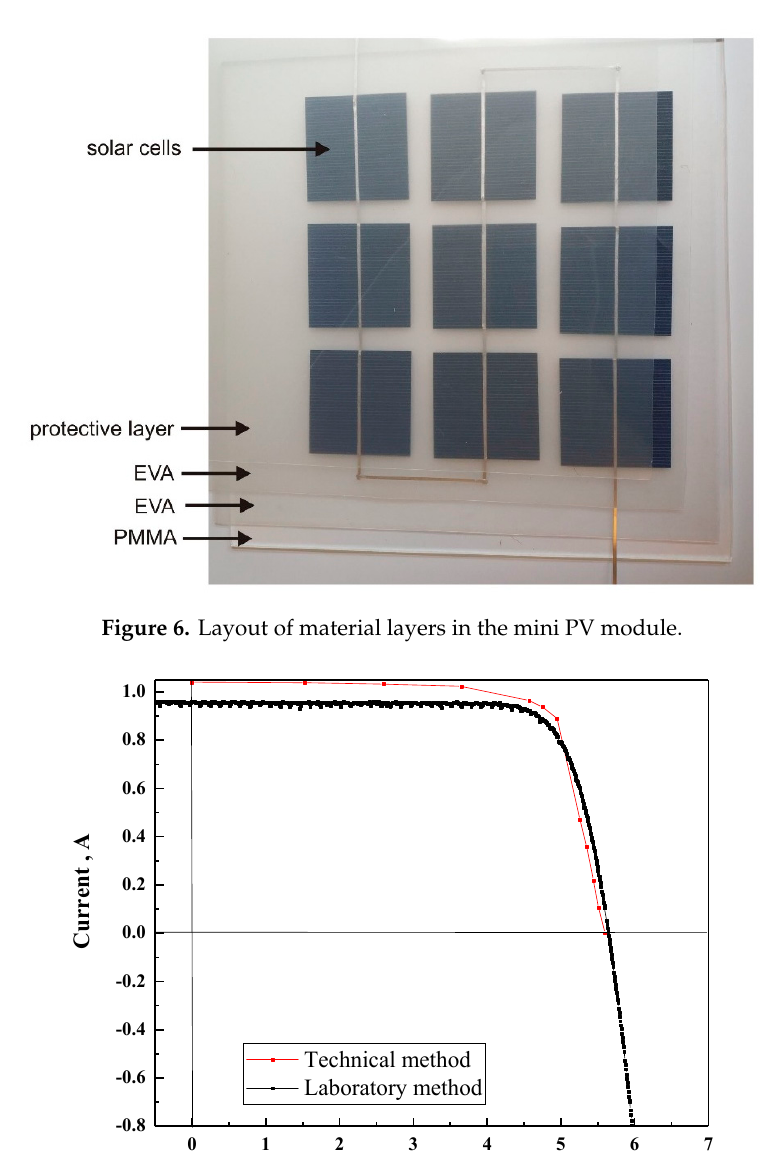
Table 1. Photovoltaic parameters of PV module investigated by laboratory and technical setup.